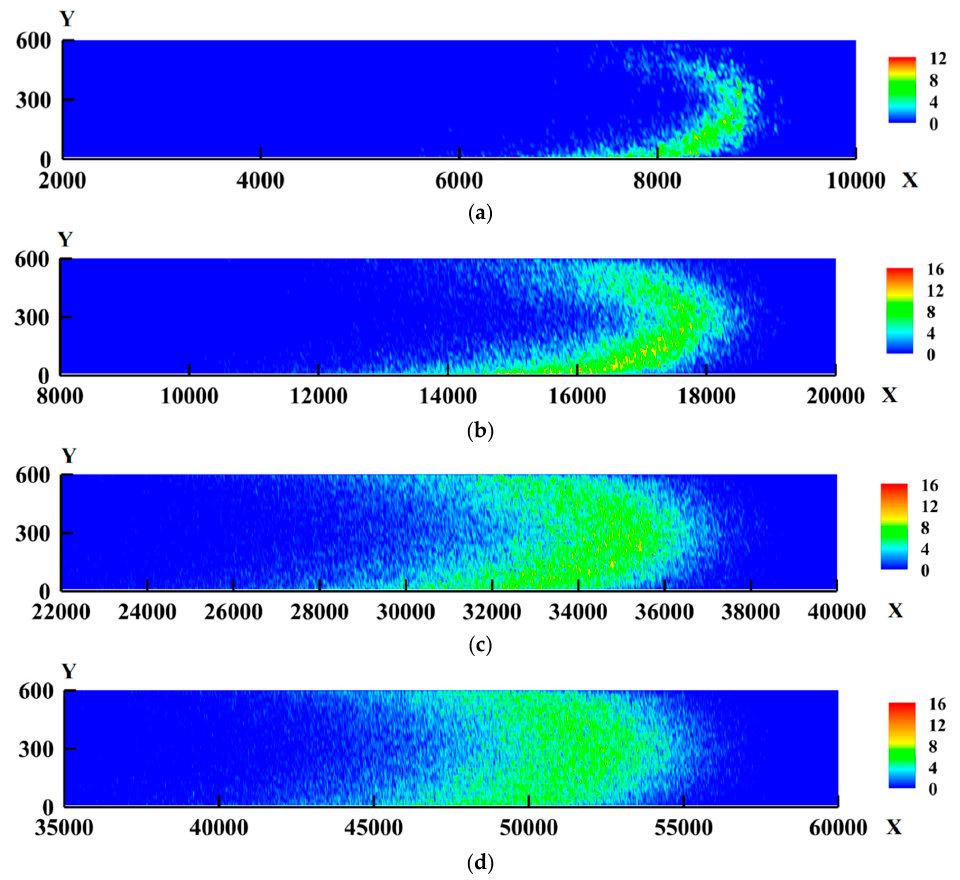
Figure 4. Development of the mixing region with time for two puffs, puff A: Sc = 0.7, y o = 300, and puff B: Sc = 2400, y o = 15. ( a ) Contours of n AB at t = 500; ( b ) Contours of n AB at t = 1000; ( c ) Contours of n AB at t = 2000; ( d ) Contours of n AB at t = 3000.